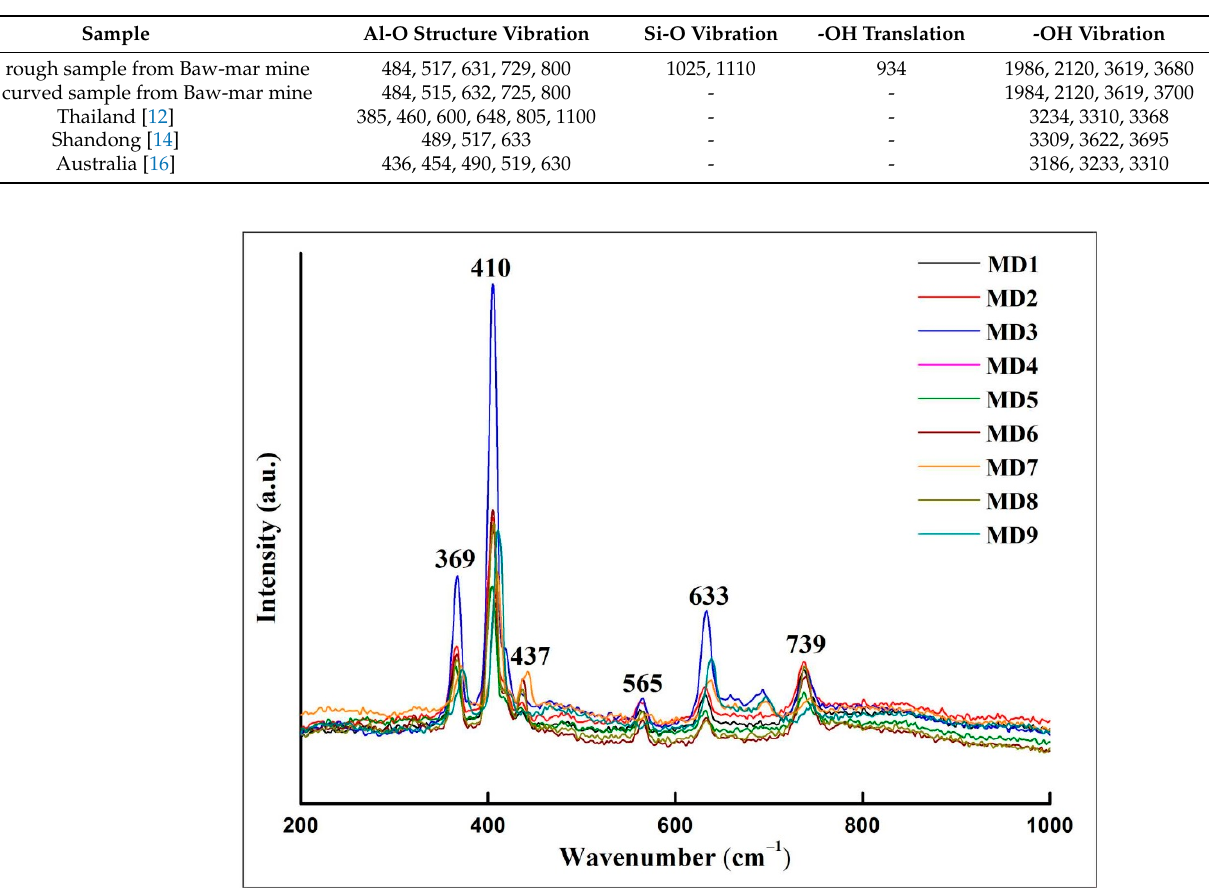
Table 3. FTIR peak frequency and attribution of sapphire in this study (cm − 1 ).